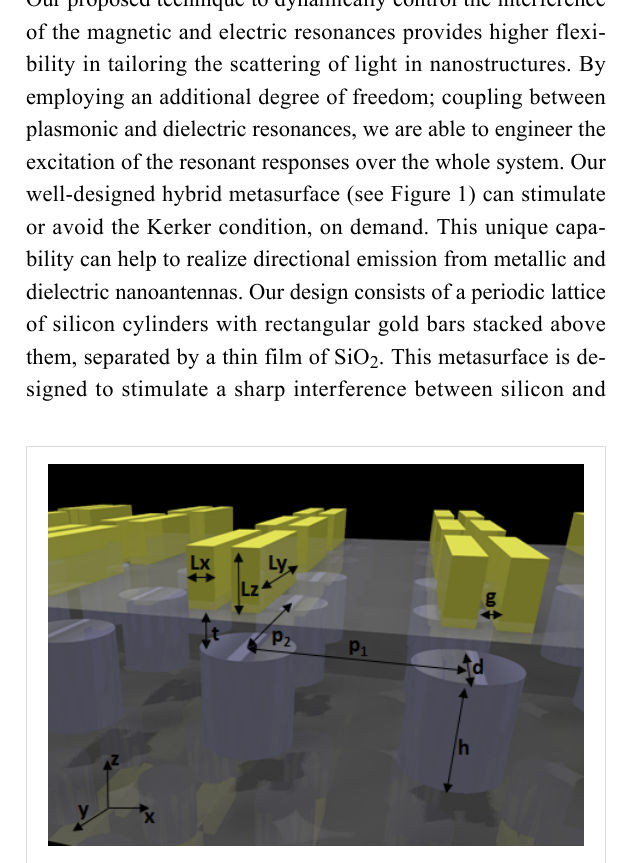
Figure 1: Diagram of the metasurface. The geometrical parameters are L x = 100 nm, L y = 600 nm, L z = 200 nm, t = 200 nm, d = 400 nm, h = 400 nm, g = 60 nm, p 1 = 850 nm, p 2 = 850